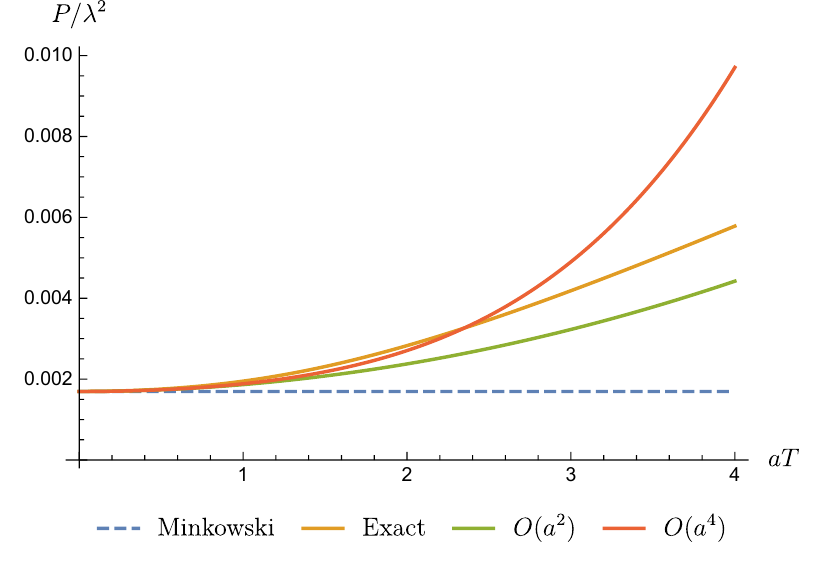
Figure 3 . ‘GW amplitude expansion’ of the excitation probability for source-less waves. Considering the source-less shockwaves with a x = − a y = a , we display the exact (orange curve), the O ( a 2 ) (green curve), and the O ( α 4 ) (red curve) amplitude expansions of the transition probability and compare them to that of the Minkowski space (blue dashed curve). As previously, the detector is located at the origin, with the switching peak at t = 0 , the shockwave follows u = 0 , and Ω T = 2